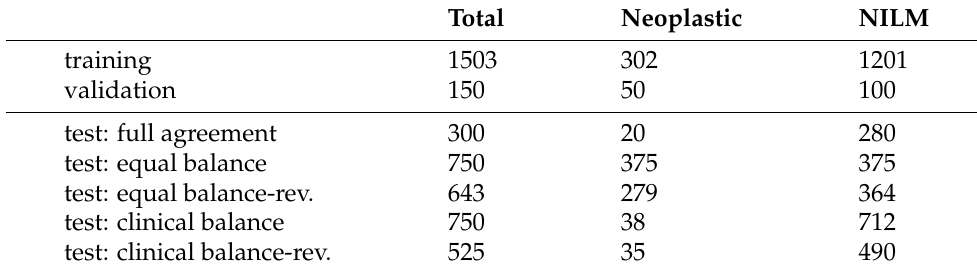
Table 1. Distribution of WSIs into training, test, and validation